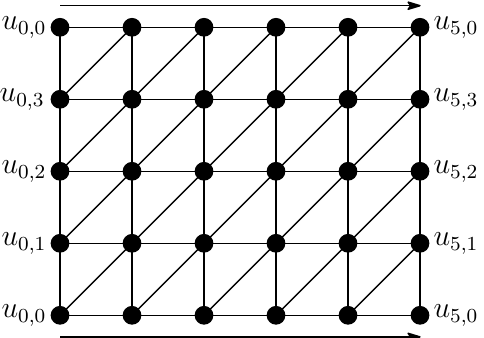
Figure 1: The graph A